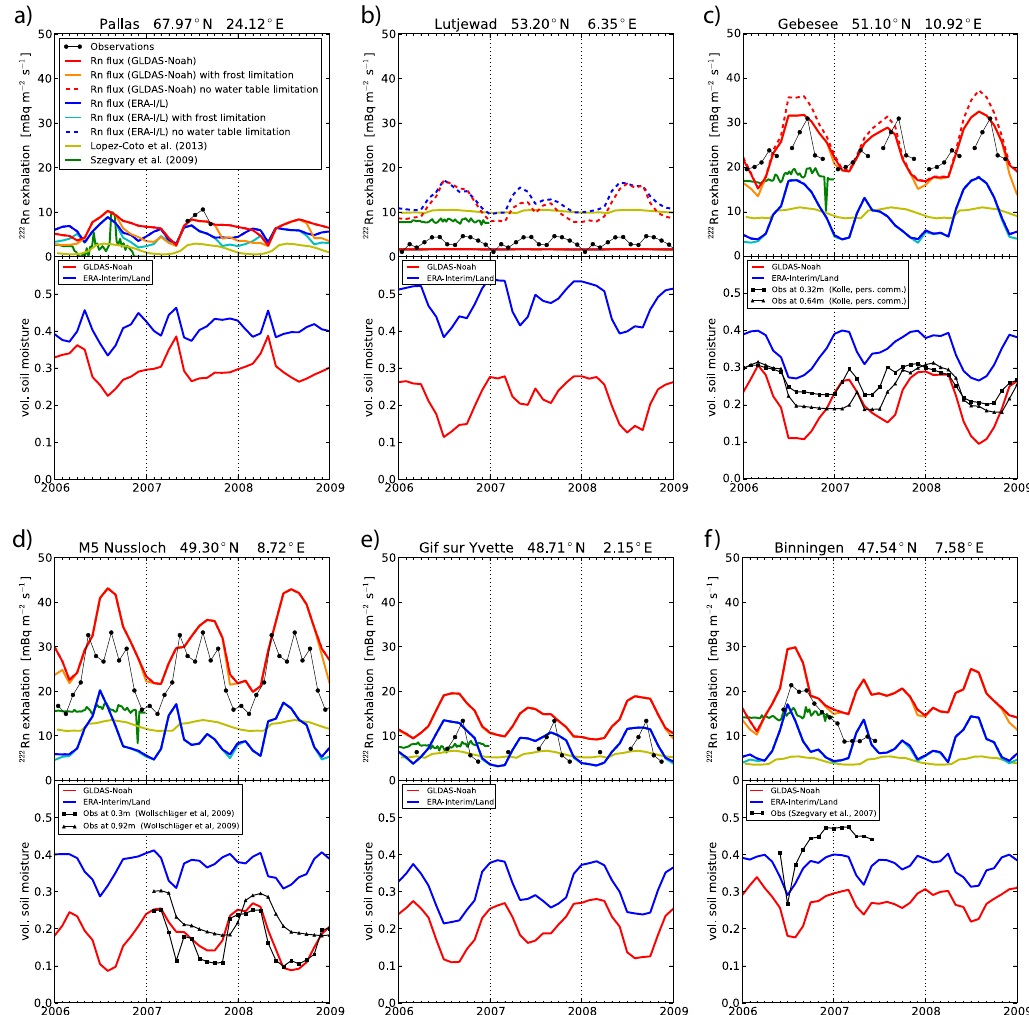
Figure 7. Upper panels of each row: Comparison of estimated 222 Rn fluxes (coloured lines) with monthly mean observations (solid black dots) at selected European sites. The flux data have been taken from the following publications: Pallas 2007 data: Lallo et al. (2009); Lutjewad multi-year mean data: Manohar et al. (2015); Gebesee 2003–2004 data: Schell (2004); M5 Nußloch 1985–1997 climatology: Jutzi (2001); Gif-sur-Yvette 2013 data: Schwingshackl (2013); Binningen 2006–2007 data: Szegvary et al. (2007b, http://radon.unibas.ch). Also included in the upper graphs of both rows are flux estimates from Szegvary et al. (2009) for the year 2006 and from López-Coto et al. (2013) for the years 1957–2002 plotted as seasonal cycle climatology. Lower panels of each row: Comparison of GLDAS Noah (red lines) and ERA-I/L (blue lines) estimated monthly mean soil moisture with observations. The soil moisture data were taken from the following publications: Gebesee: data from O. Kolle (personal communication, 2013); M5 Nußloch: Grenzhof data from Wollschläger et al. (2009); Binningen: Szegvary et al. (2007b,